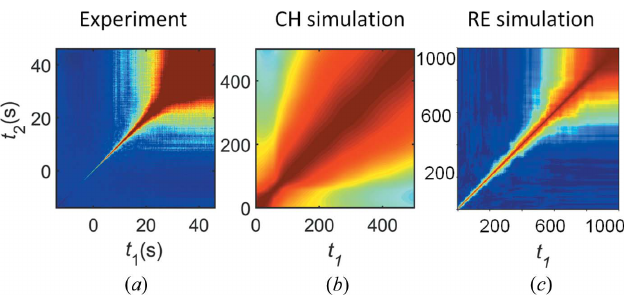
Figure 5 Particle-based simulation of a two-stage process. The bottom row demonstrates the evolution of the radii of particles with time. The upper row shows the corresponding calculated TTCs for the same q value. The speed of growth in the first stage (time < 200 arb. u.) is the same, followed by the different rates of the second stage. This stage is dissolution in ( a ) and ( b ), no change in size in ( c ), and growth in ( d ) and ( e